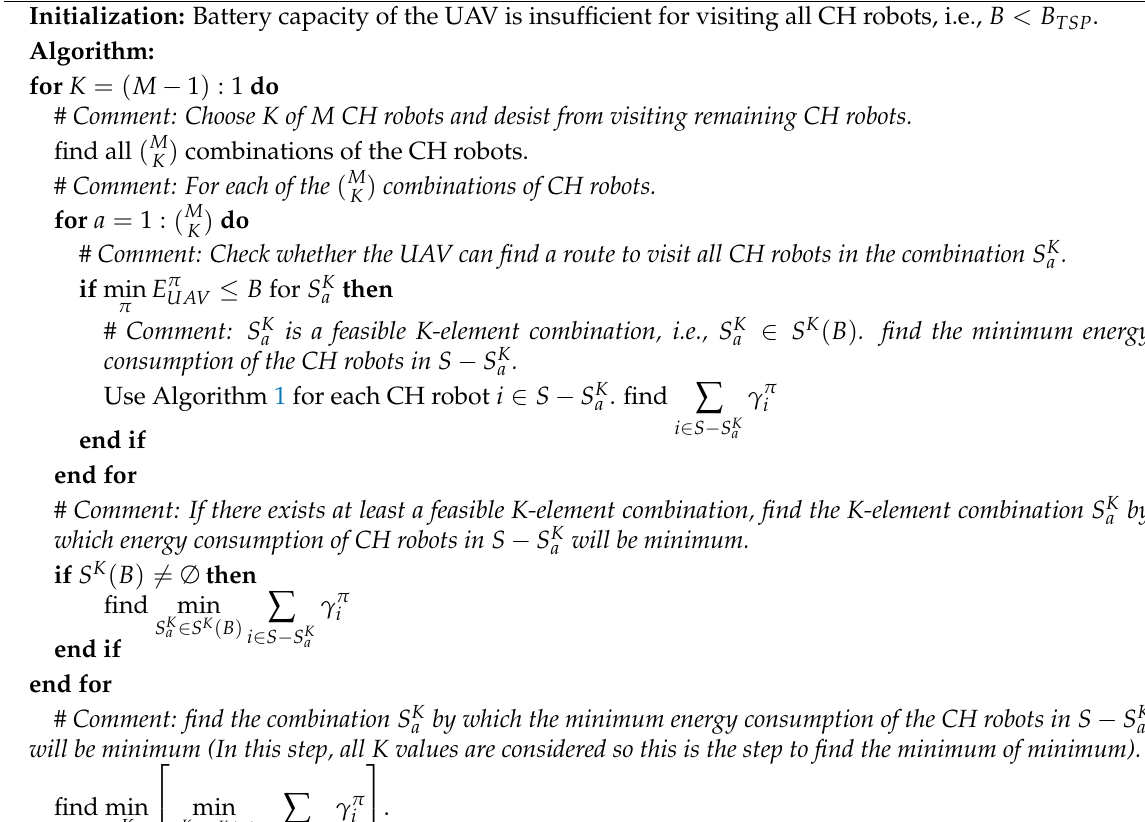
Algorithm 2 Genetic Algorithm with Minimum Energy for Data Forwarding